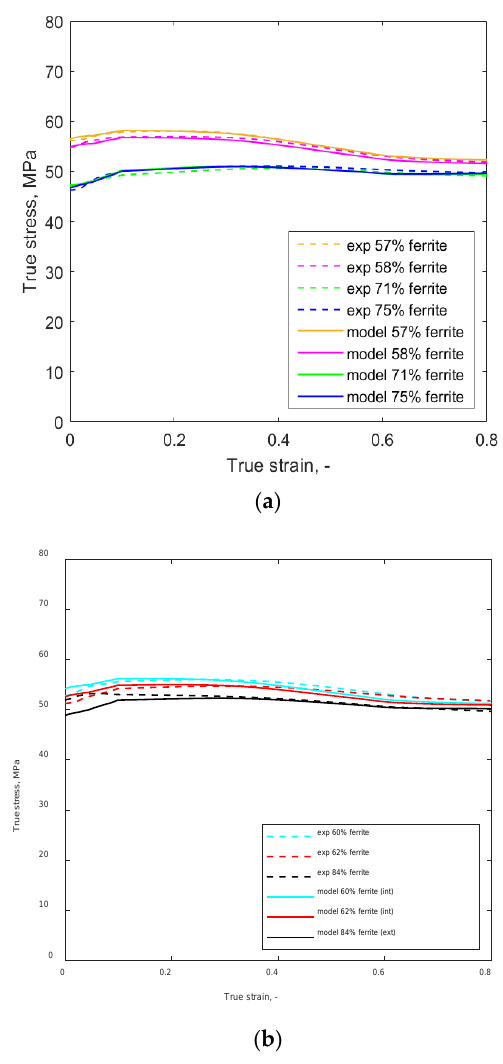
Figure 9. ( a ) Comparison of experimental and calculated stress-strain curves of material conditions that were used to calculate the mean single-phase curves. ( b ) Comparison of experimental and calculated stress-strain curves of material conditions that are inter- (int) and extrapolated (ext) with the duplex model.